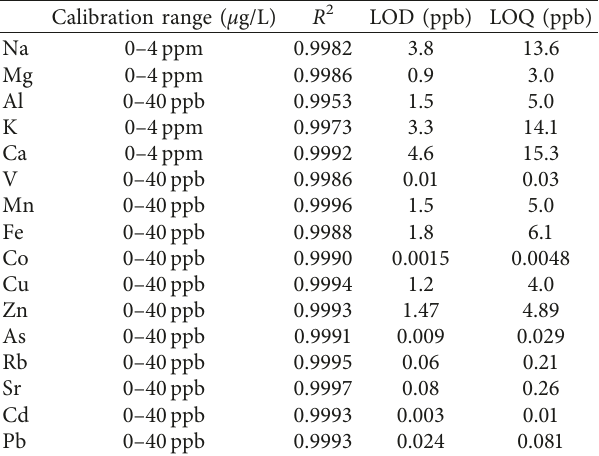
Table 3: Elements for all rice samples harvested in the year of 2013 and 2014 among three different regions ( µ g · g − 1 ).